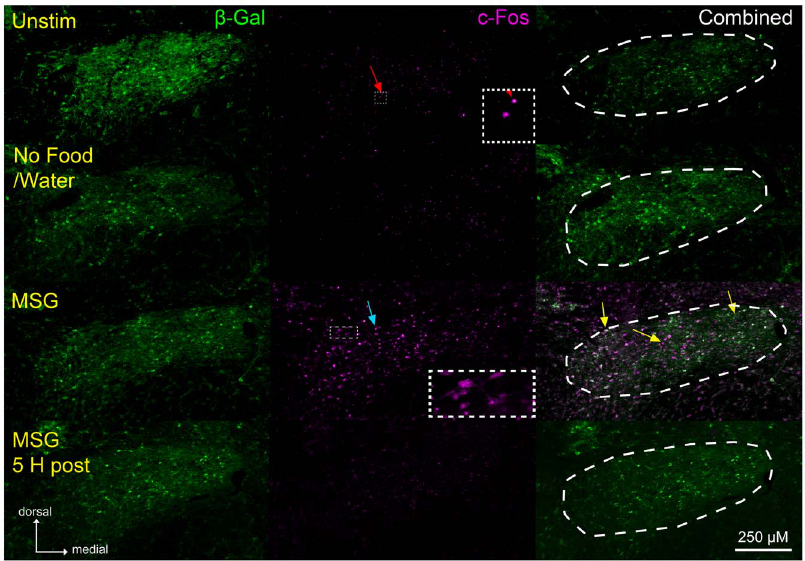
Figure 2. b – galactosidase staining is similar across experimental conditions; whereas c-Fos protein label varies significantly. Left : b -gal staining (green) is not different across all experimental groups. Middle : Significant c-Fos staining (magenta) is present only in the MSG group. However, punctate c-Fos staining (red arrow) is found in all other groups. Moreover, c-Fos protein staining is found in the cellular processes of some c-Fos labeled cells in the MSG group (inset). Right : A significant proportion of doubled labeled c-Fos/ b -gal cells (white label and left most yellow arrow) is found in the MSG group. Interestingly, we observed some c-Fos positive cells that were not co-labeled with b -gal (middle yellow arrow) as well as some b -gal positive cells that did not co-localize with the c-Fos protein (right yellow arrow). Sections shown are of the ‘Rostral’ representative level.